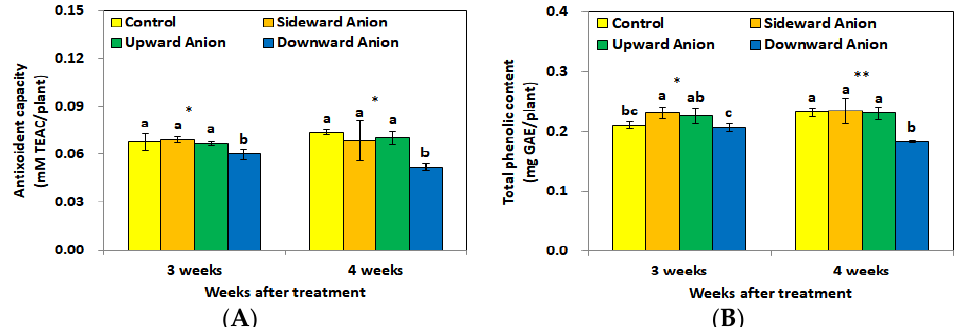
Figure 4. Comparison of ( A ) antioxidant capacity and ( B ) total phenol content of lettuce relative to air anion generation position. Values are mean ± standard error ( n = 3). * and ** indicate correlations are significant at the 0.05 and 0.01 levels, respectively.